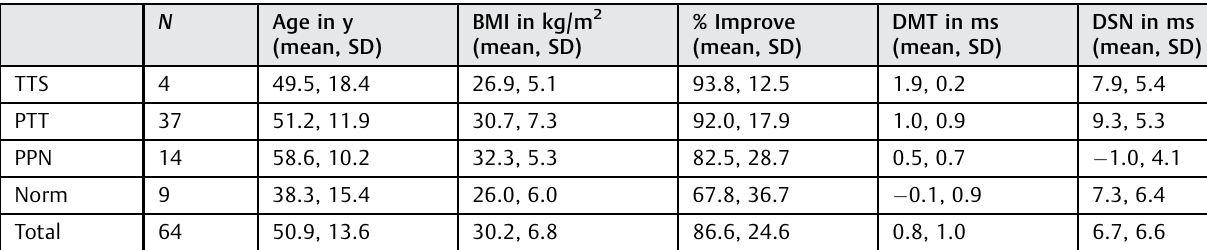
Table 2 Strati fi ed groups based on age, BMI and percentage of improvement patient rating, delta motor – and delta sensory – derived variables following